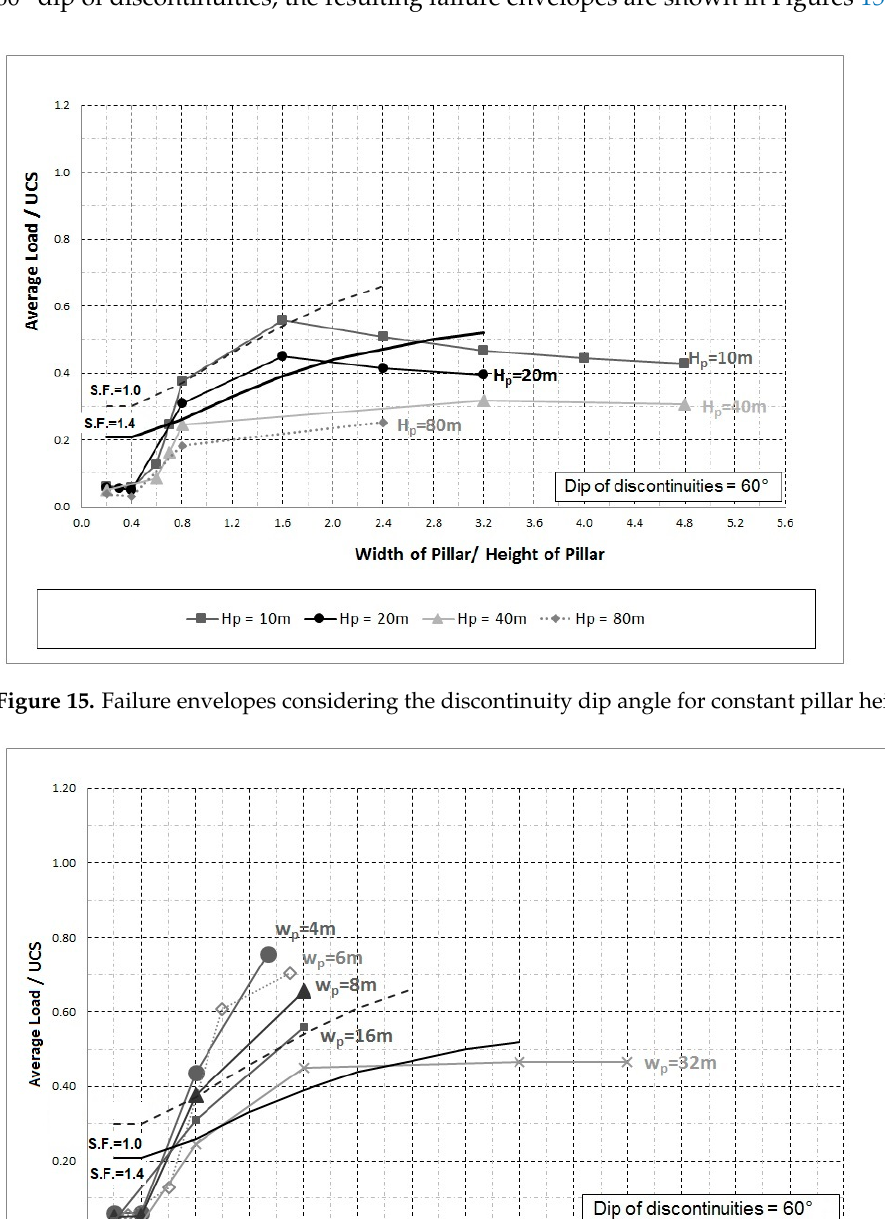
Figure 14. Effect of discontinuity cohesion on pillar strength.